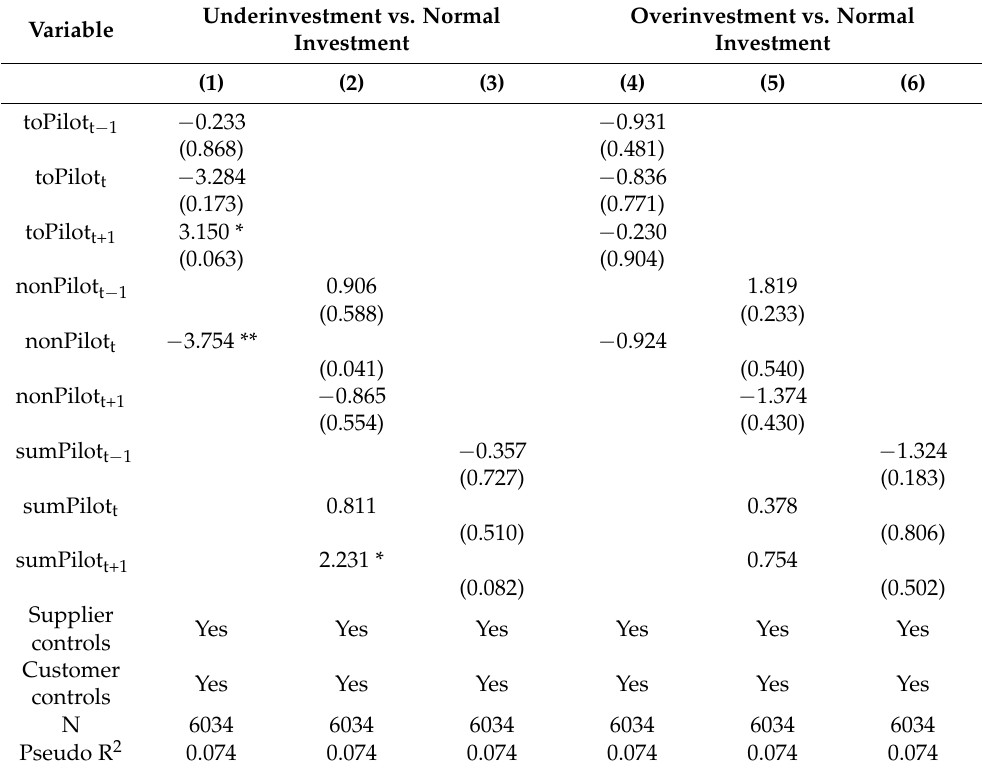
Table 8. Endogeneity concerns: Pilot